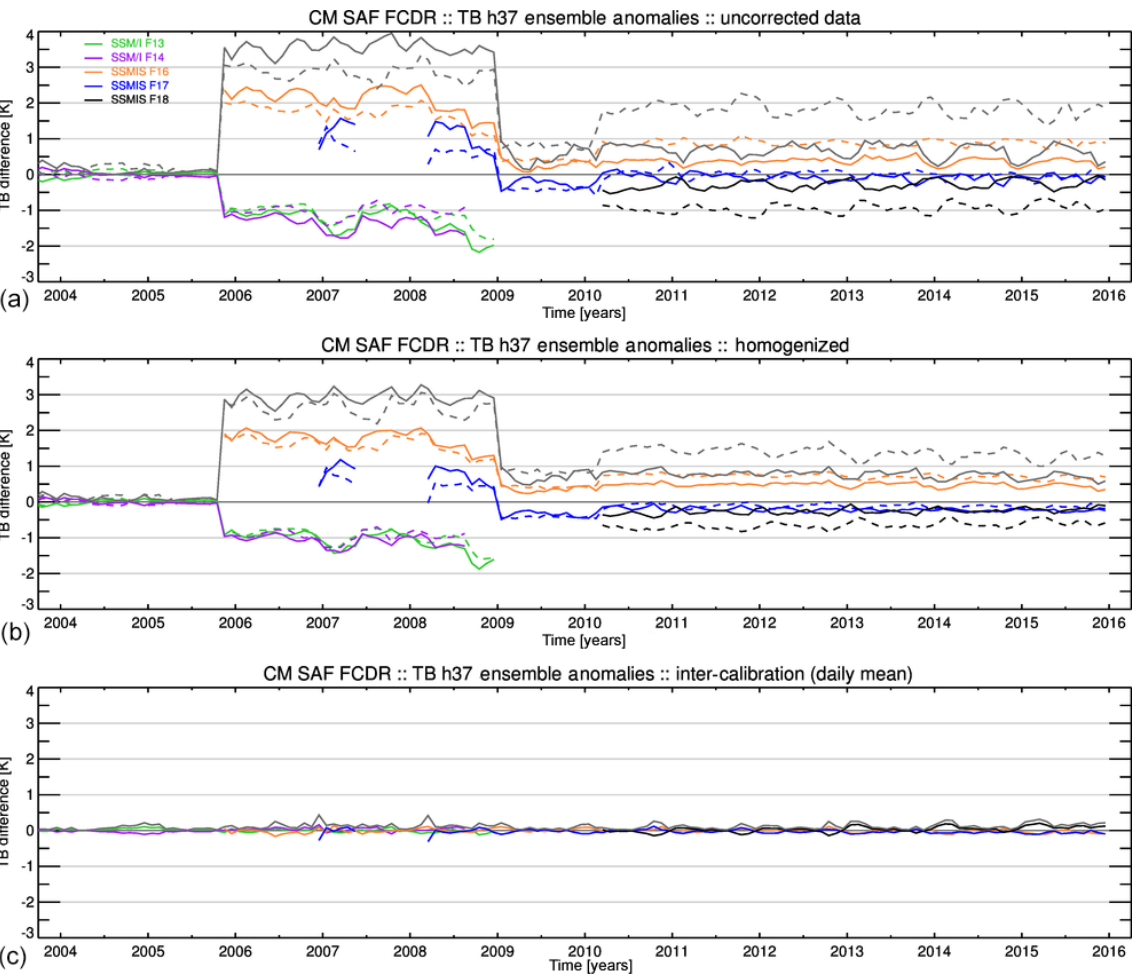
Figure 8. Time series of ensemble anomalies for SSM/I and SSMIS channels at 37GHz, h-pol. In (a) and (b) the solid lines are PM orbits and the dashed lines AM orbits. Panel (c) shows daily means of AM and PM orbits. The grey lines depict the maximum difference observed between any two sensors (ensemble spread). For a detailed description see text. Colours are as follows: F16 – orange; F17 – blue; F18 – black; F13 – green; F14 –